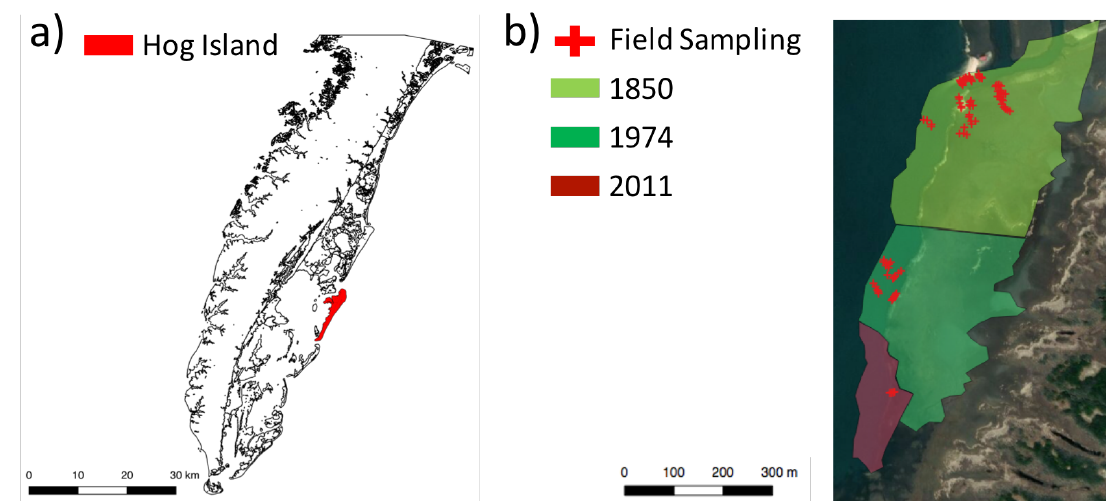
Figure 1. ( a ) Site Map of the Delmarva Peninsula, VA, including the barrier islands, estuaries, and shallow bays of the VCR/LTER, with Hog Island shown in red. ( b ) Our study site during the 2017 field campaign on Southern Hog Island. The figure shows the in situ measurements used in this study, covering marshes of three different ages established between ∼ 1850 to